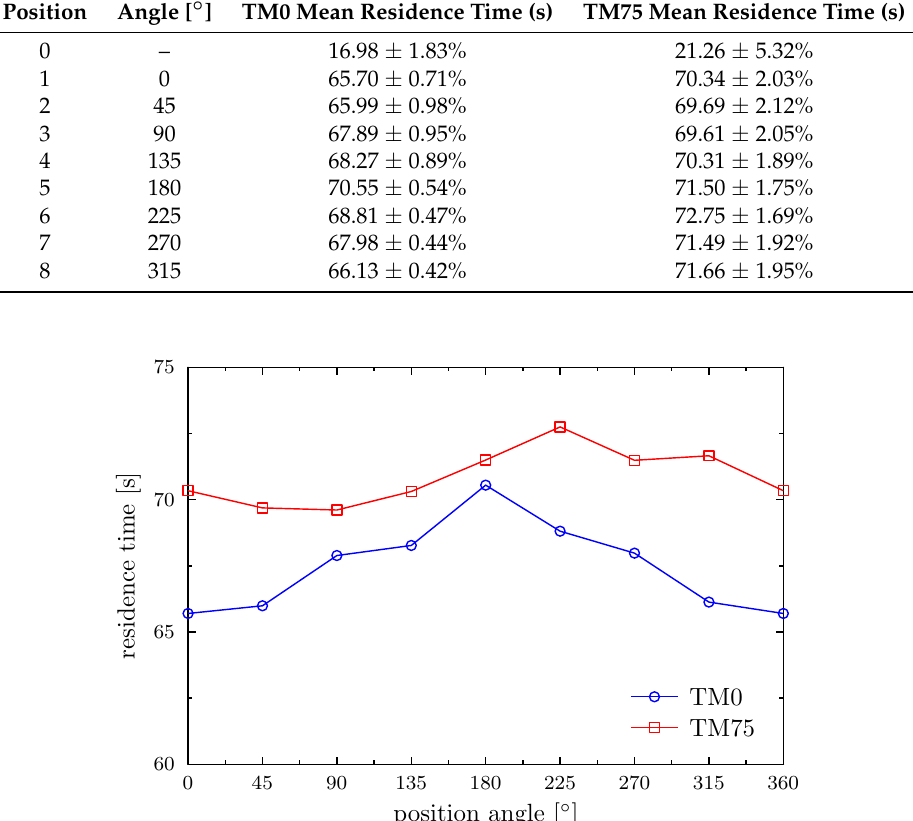
Table 5. Impact of the injection position on the mean residence time. Positions of injections 0–8 are depicted on Figure 11. In all cases, samples of 500 particles reflecting the Rosin–Rammler distribution parameters determined in the experimental part were injected at the liquid surface in a circular area around the corresponding points.